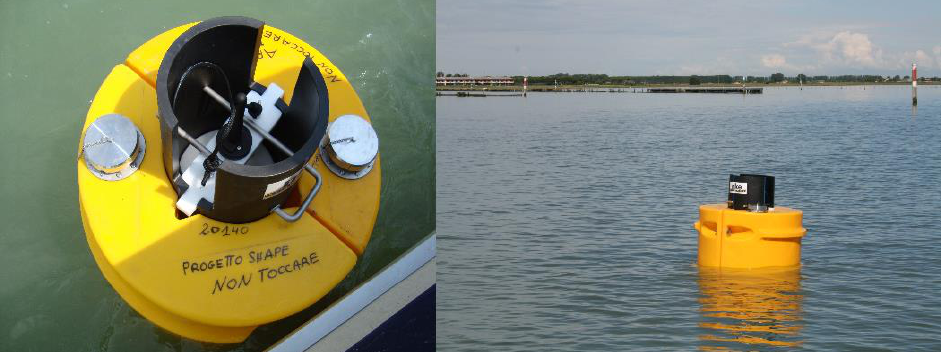
Figure 2. Example of probe deployment in the Marano and Grado Lagoon.